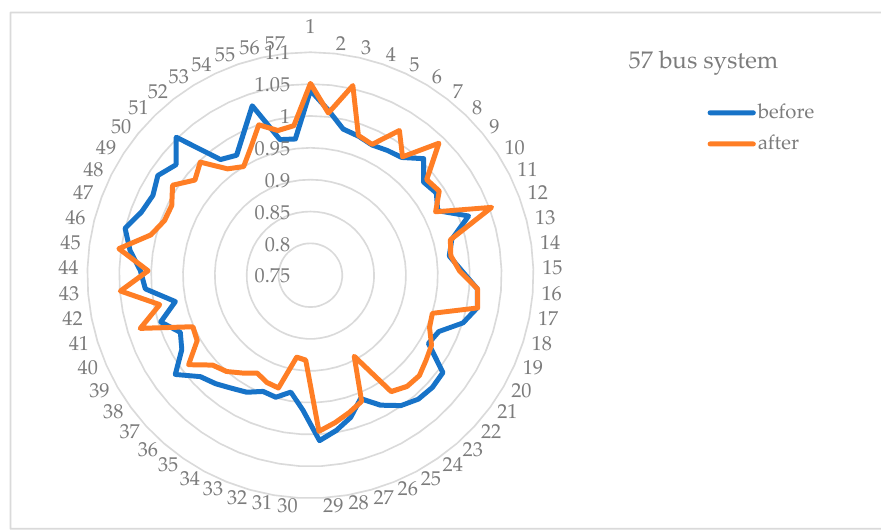
Figure 9. Power losses obtained by different optimization methods for the 57 bus system.